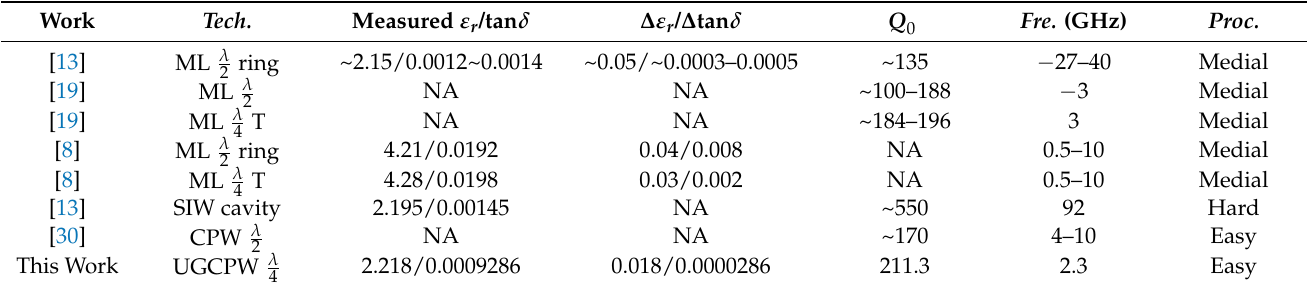
Table 2. Comparison among different resonator-based methods for dielectric characterization.